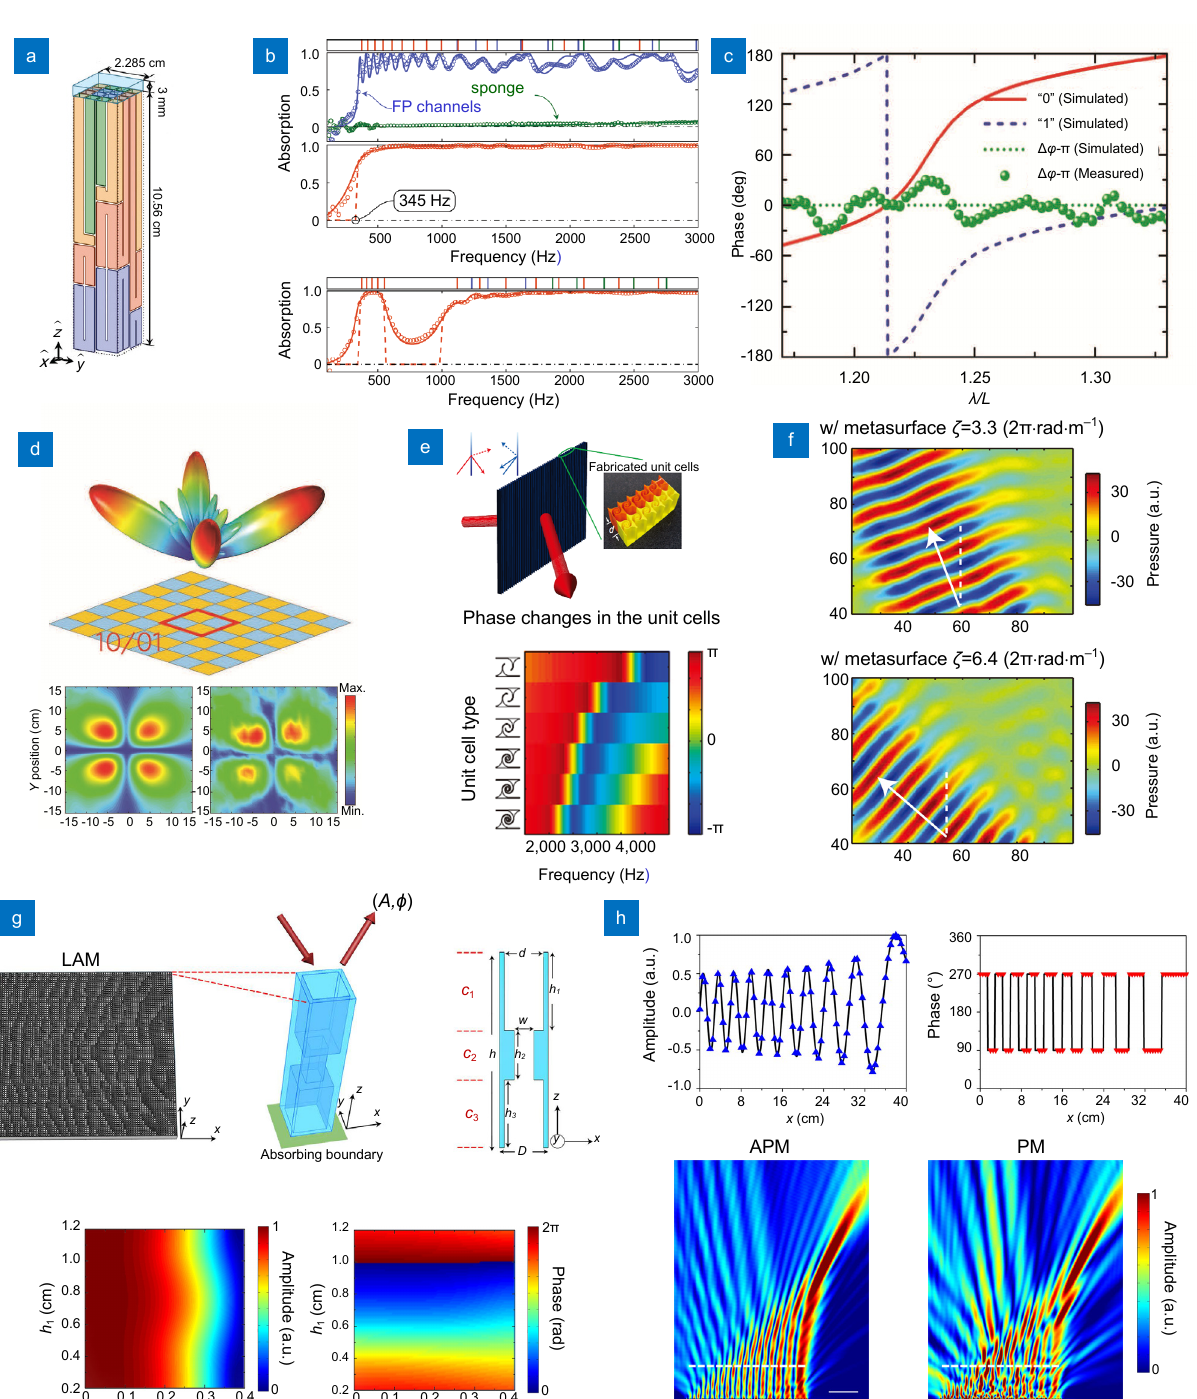
Fig. 6 | ( a ) Schematic of the folded Fabry-Pérot tube array for realizing structures with target-set absorption spectra. ( b ) Absorption spectra caused by Fabry-Pérot resonance, which is close to the theoretical limit in the semi-infinite frequency range. ( c ) The transmission phase of two coding elements. ( d ) Simulated far field distribution (upper) and simulated (lower left) and measured (lower right) field amplitude distributions of the transmitted waves divided into four beams when coding elements are distributed in a checkerboard pattern. ( e ) Schematic of generalized Snell’s law realized by a series of tapered labyrinthine metamaterials (upper) and the phase changes of six types of unit cells (lower). ( f ) Measured anomalous refraction caused by controlling the wavefront phase with arrangement of the unit cells. ( g ) The decoupled effect of amplitude-phase (lower) caused by the holey structured lossy acoustic metamaterial (upper). ( h ) Upper panels: amplitude (left) and phase (right) profiles of the lossy acoustic metamaterial for generating the Airy beam. Lower panels: comparison of the Airy beam formed by amplitude phase modulation (APM) (left) and Phase modulation (PM) (right). Figure reproduced from: (a–b) ref. 210 , Royal Society of Chemistry; (c–d) ref. 213 , Wiley-VCH; (e–f) ref. 216 , Nature Publishing Group; (g–h) ref. 226 , Nature Publishing